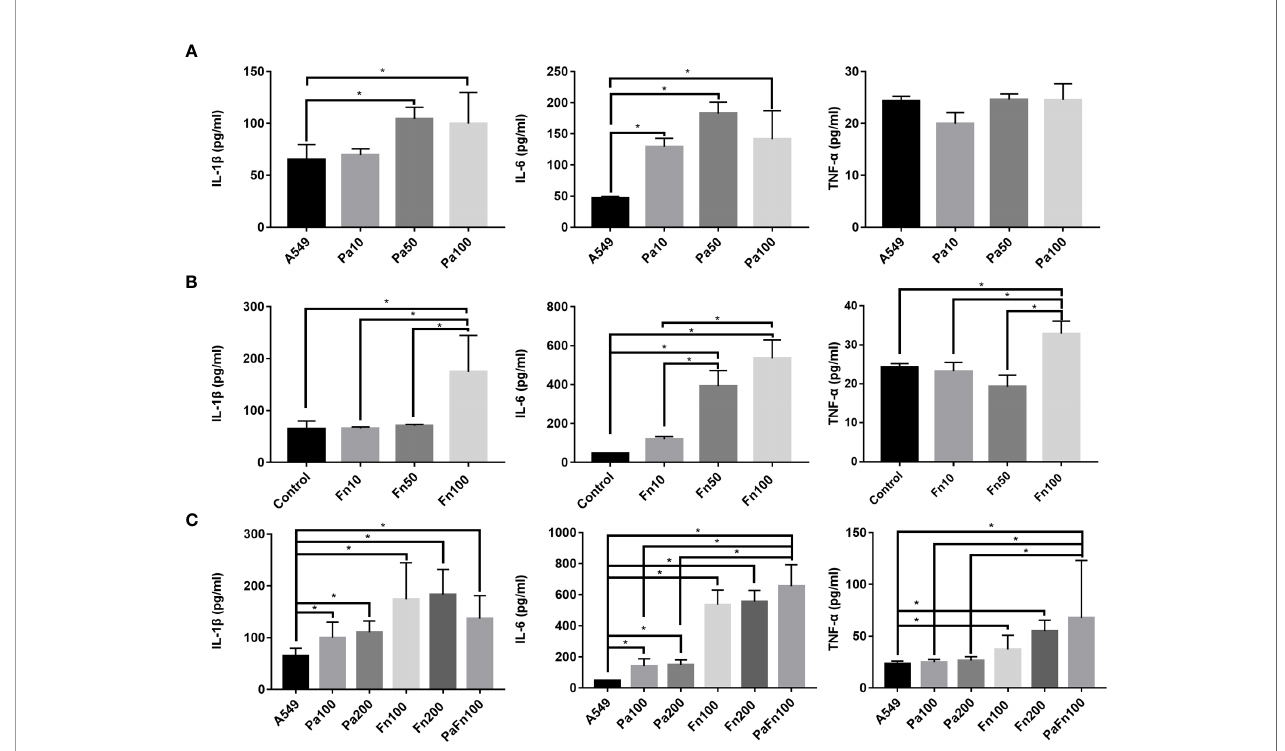
FIGURE 4 | The effect of P. aeruginosa and F. nucleatum on IL-1 b , IL-6 and TNF- a productions. (A) The effect of P. aeruginosa on IL-1 b , IL-6 and TNF- a productions of pulmonary epithelial cells. A549 cells were infected with different MOI (10, 50, 100) of P. aeruginosa for 24 h. (B) The effect of F. nucleatum on IL-1 b , IL-6 and TNF- a productions of pulmonary epithelial cells. A549 cells were infected with different MOI (10, 50, 100) of F. nucleatum for 24 h. (C) The effect of the simultaneous infection of P. aeruginosa and F. nucleatum on IL-1 b , IL-6 and TNF- a productions of pulmonary epithelial cells. A549 cells were simultaneously infected with P. aeruginosa (MOI 100) and F. nucleatum (MOI 100) for 24 h, and the single P. aeruginosa or F. nucleatum infection groups (MOI 100, 200) were used as control. * P < 0.05, statistics were achieved by analysis of variance followed by Sidak ’ s multiple comparisons test. Pa, P. aeruginosa ; Fn, F. nucleatum